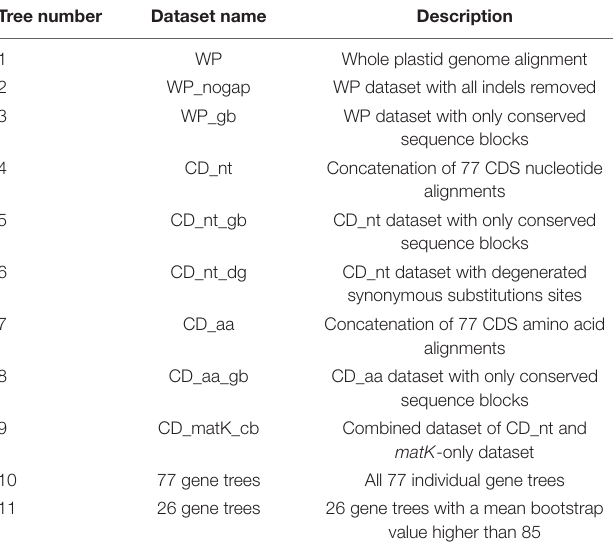
TABLE 1 | Descriptions for 11 datasets used for plastid phylogenomic analyses in this study. Tree